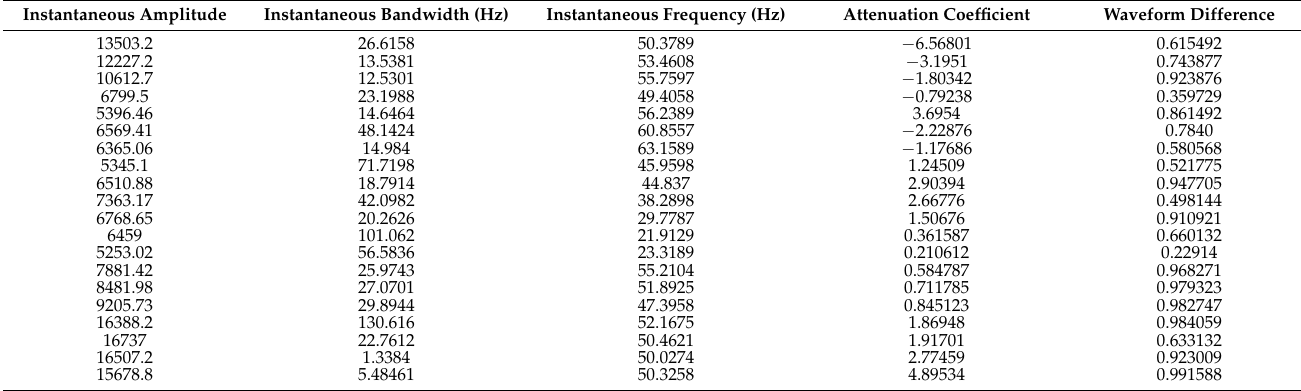
Table 3. Partial seismic attribute samples for support vector machine learning (non-faults).